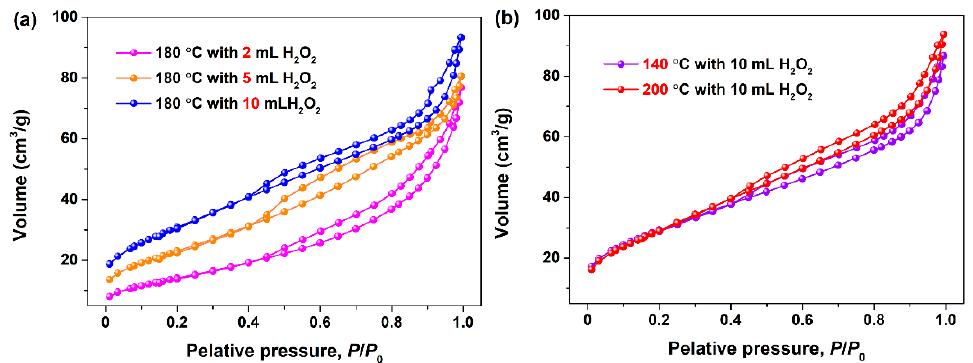
Figure 3. N 2 adsorption–desorption isotherms of the mesoporous CeO 2 synthesized hydrothermally ( a ) at 180 °C for 24 h with a desired amounts H 2 O 2 of 2, 5 and 10 mL, and ( b ) the mesoporous CeO 2 synthesized hydrothermally at a set temperature of 140 and 200 °C for 24 h with 10 mL H 2 O 2 . Table 2. Physicochemical properties of the mesoporous CeO 2 synthesized hydrothermally at 180 °C for 24 h with a desired amounts H 2 O 2 of 2, 5 and 10 mL, and the mesoporous CeO 2 synthesized hydrothermally at a set temperature of 140 and 200 °C for 24 h with 10 mL H 2 O 2 . Synthesis Conditions